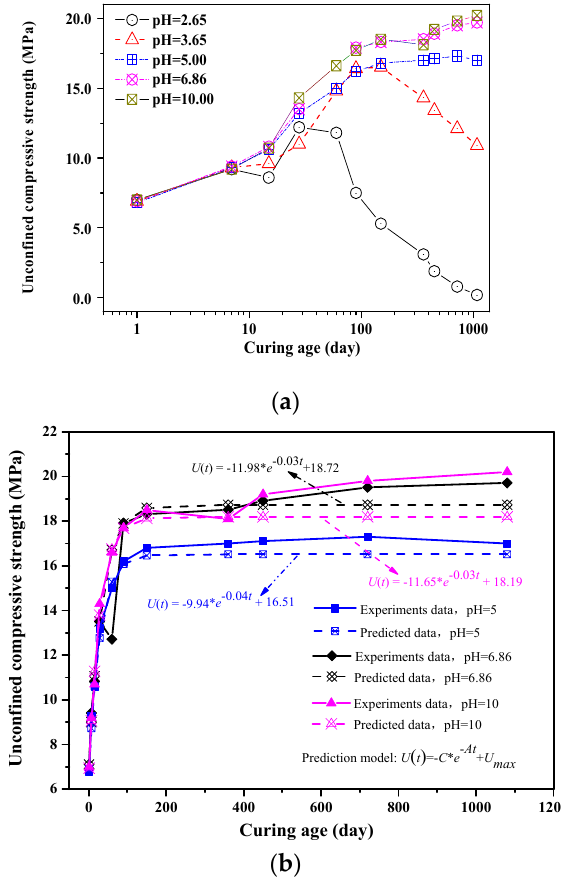
Figure 4. UCS variation as a function of time under different pH conditions: ( a ) experimental data for the S/S monoliths; ( b ) comparison data.